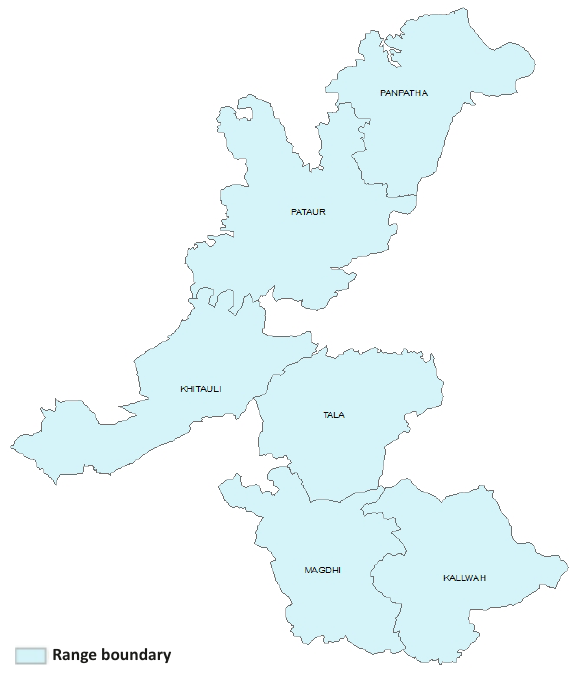
Range Figure 2. Different ranges of the Bandhavgarh Tiger Reserve